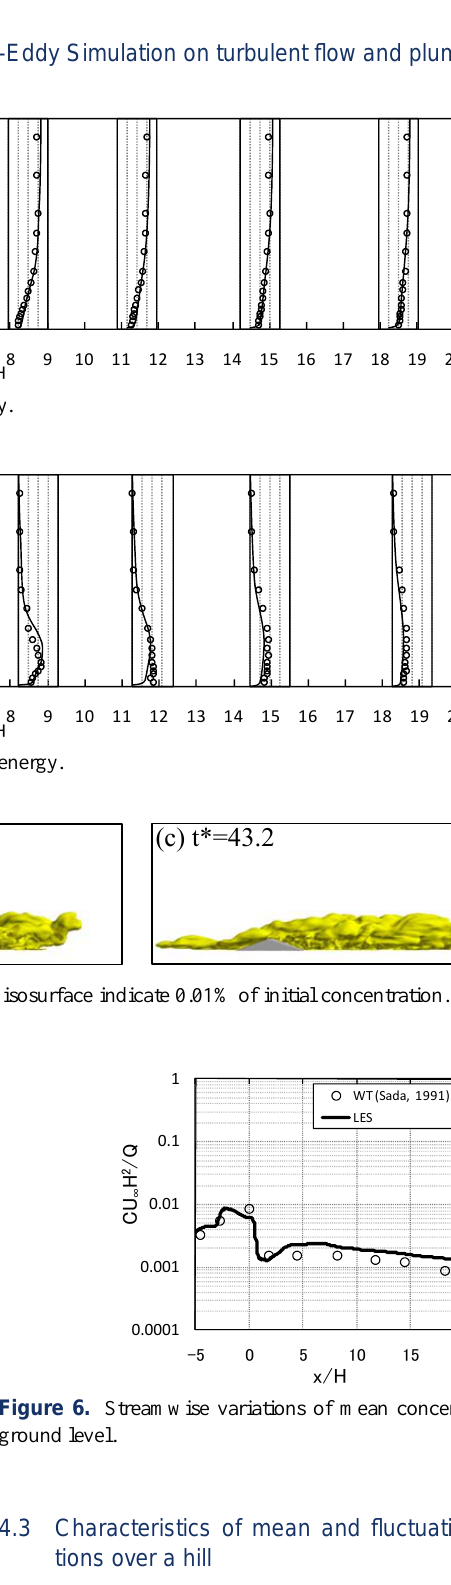
Fig. 1. Schematic illustration of computational model. (a)Driver region for generation of a spatially-developing TBL flow and (b)main region for plume dispersion over hill. (a)Driver region